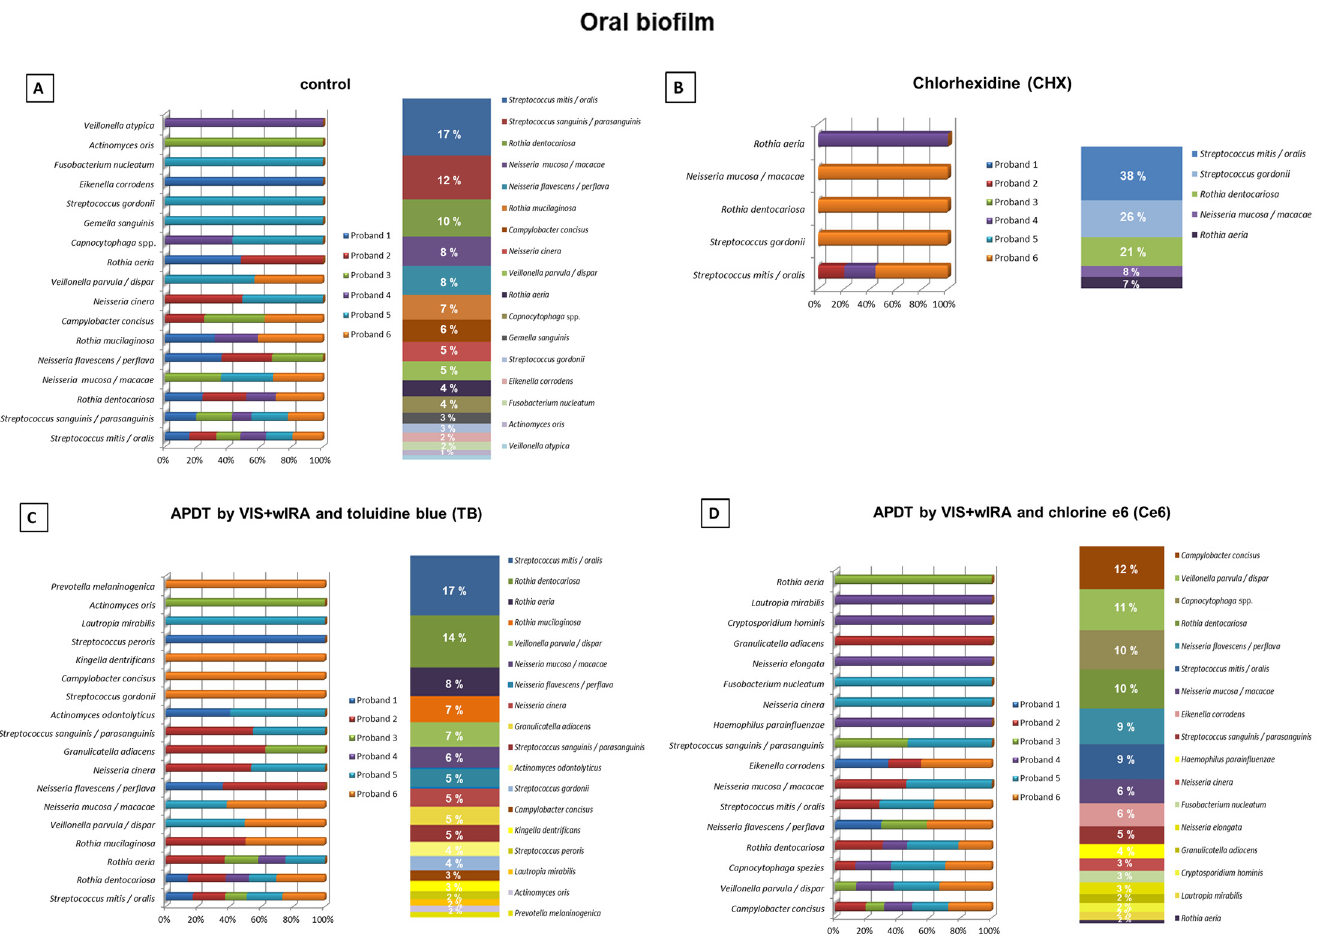
Fig 5. Relative distribution among volunteers and total distribution in percentages of oral biofilm bacterial species from 6 individuals after the application of antimicrobial photodynamic therapy (aPDT) using visible light (VIS) plus water-filtered infrared-A (wIRA). Graph A depicts bacterial composition of the untreated negative controls. Graph B demonstrates bacterial composition of the 0.2% chlorhexidine (CHX)-treated positive controls. Graphs C and D show the bacterial composition after the ex vivo treatment with VIS + wIRA and the photosensitizers (100 μ g/ml) toluidine blue (TB) and chlorine e6 (Ce6) after 3-day (d) cultivation of the oral microorganisms in situ . Consistent color coding was used for the study participants and detected bacteria as indicated by the schemes at the left and right of panels A, B, C and D respectively.